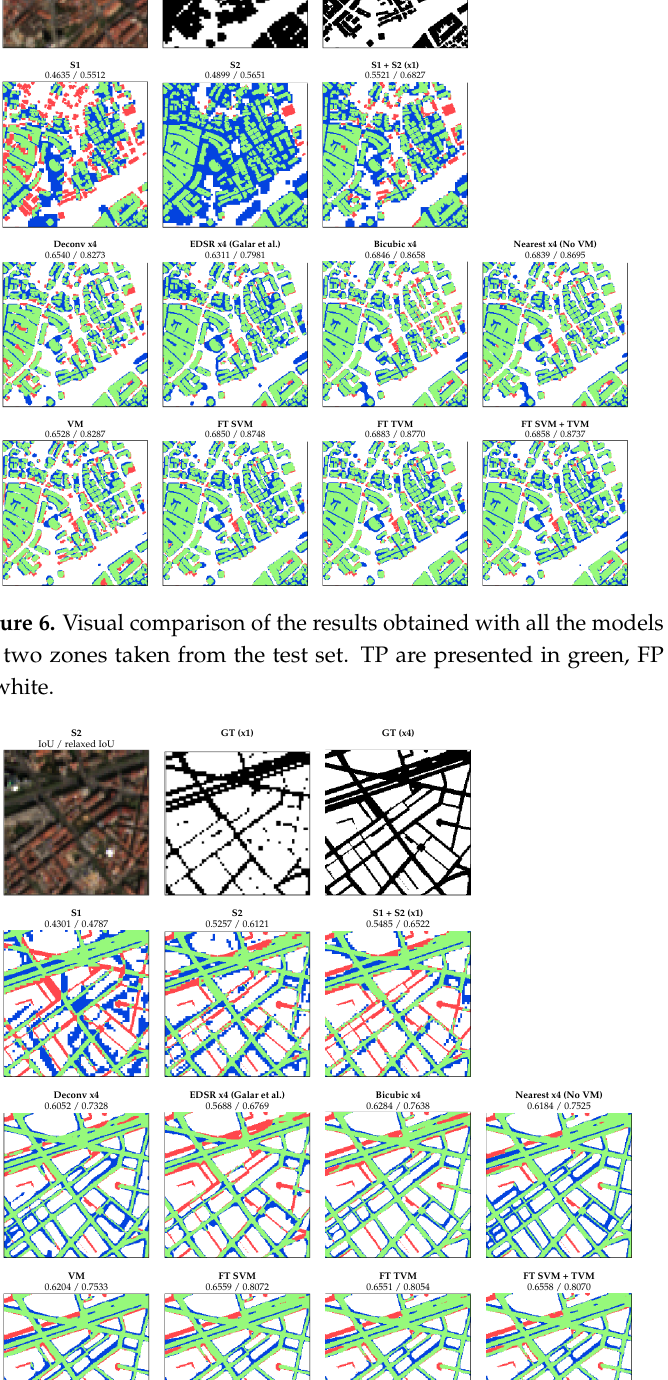
Figure7. Visualcomparisonoftheresultsobtainedwithallthemodelsincludedintheexperiments,fortwozonestakenfromthetest set. TParepresentedingreen,FPinblue,FNinredandTNinwhite. Figure 7. Visual comparison of the results obtained with all the models included in the experiments, for two zones taken from the test set. TP are presented in green, FP in blue, FN in red, and TN in